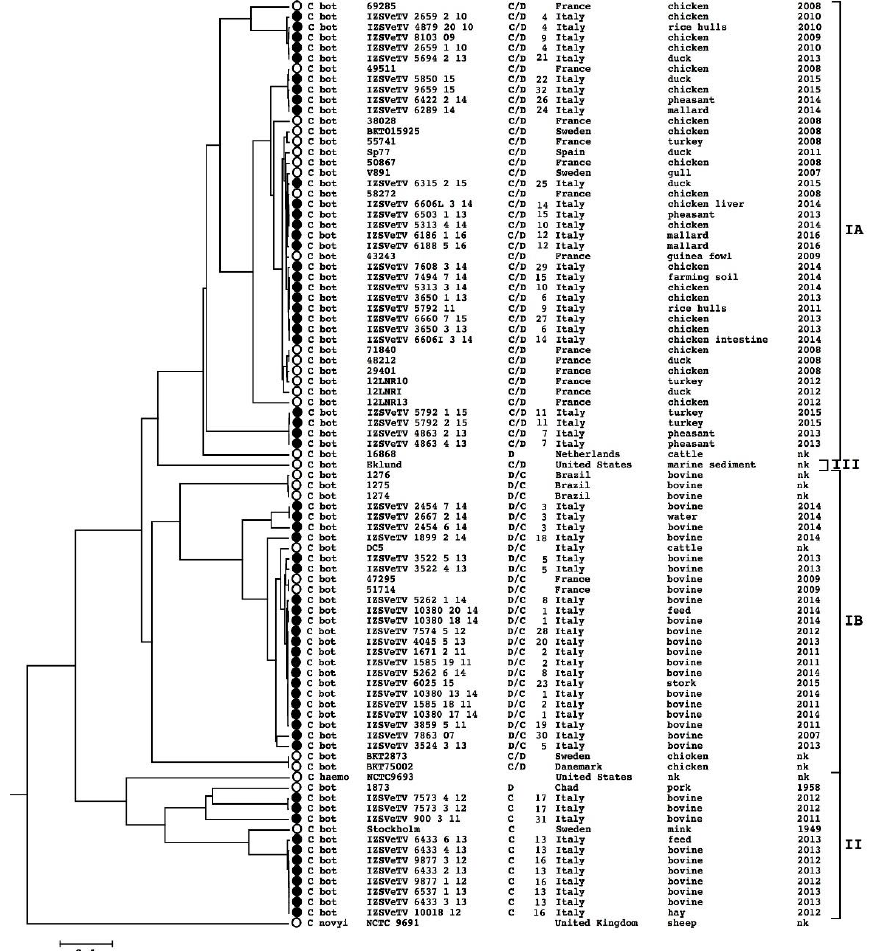
Figure 3. Dendrogram representing the phylogenetic relations among the BoNT-gene-carrying plasmid sequences of the analyzed strains, as calculated using Gegenees software. The new sequenced genomes are marked with black dots, while the genomes already analyzed in previous studies are marked with white dots. The group designations are the same used for the genome sequence classification. For each sample, the information shown in the Figure are, from left to right: species, sample name, serotype, outbreak ID, geographical origin, isolation source, isolation year.